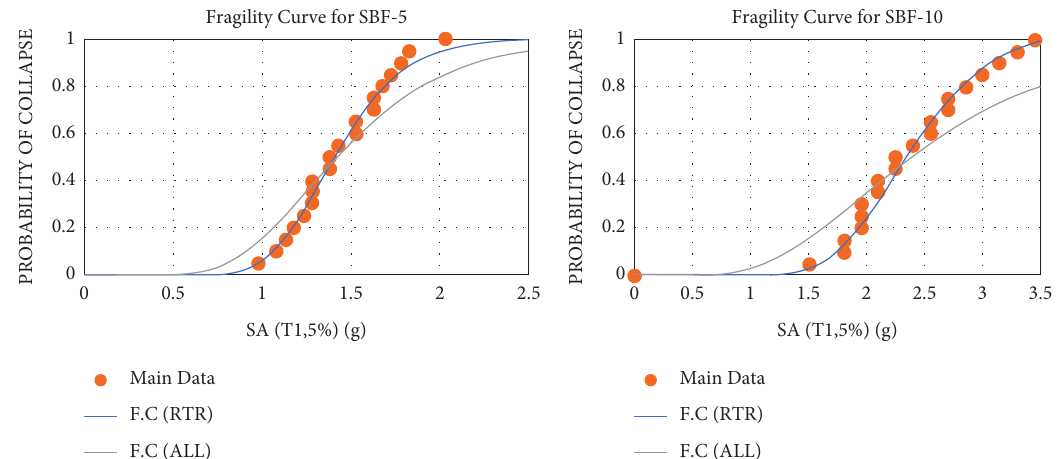
Figure 24: Fragility curves of SBF-5 and SBF-10 frames with all uncertainties.